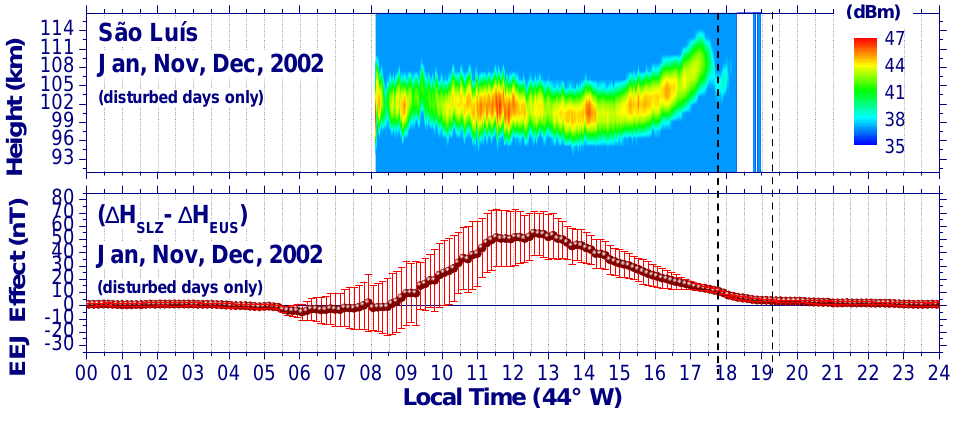
Fig. 2. Same as figure 1 but for the disturbed period ( K p > 3 + Figure 2. Same as figure 1 but for the disturbed period ( K